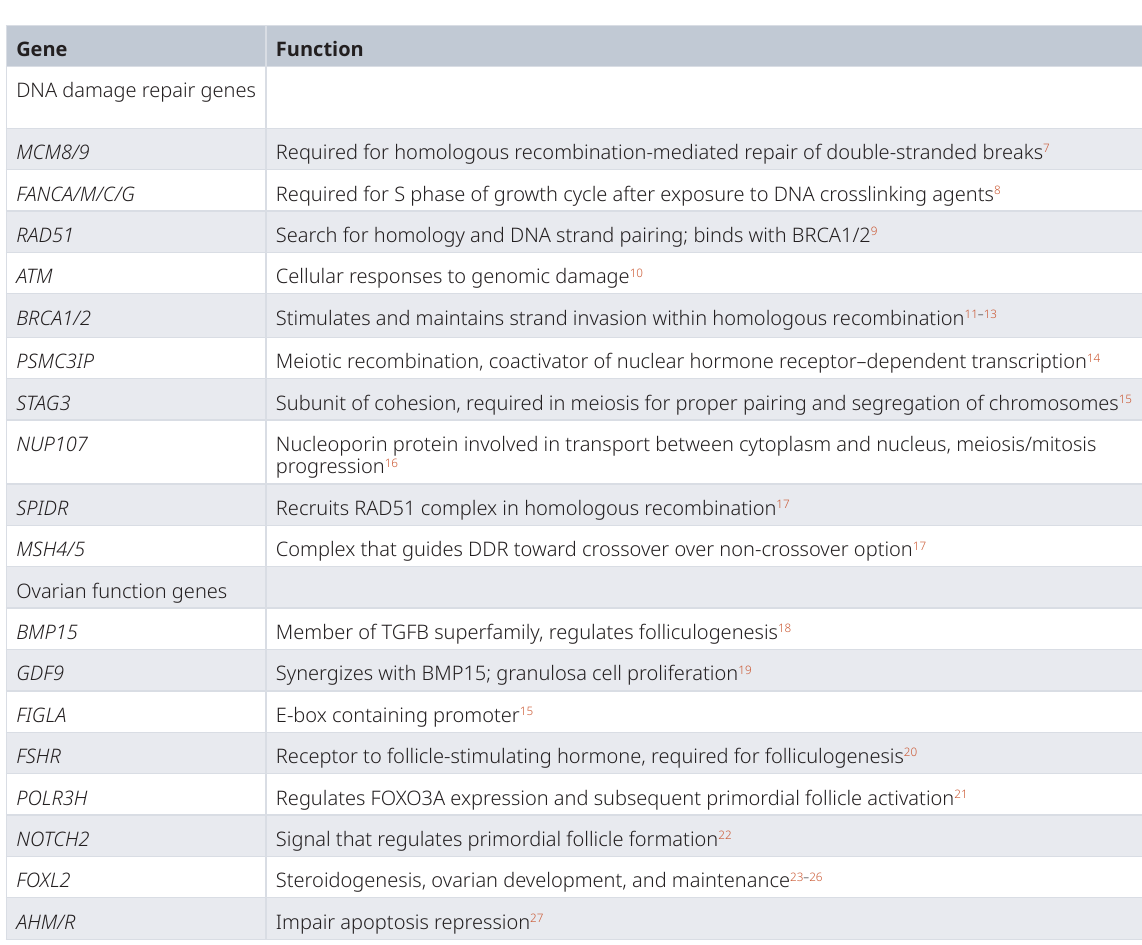
Table 3. Selected single genes associated with primary ovarian